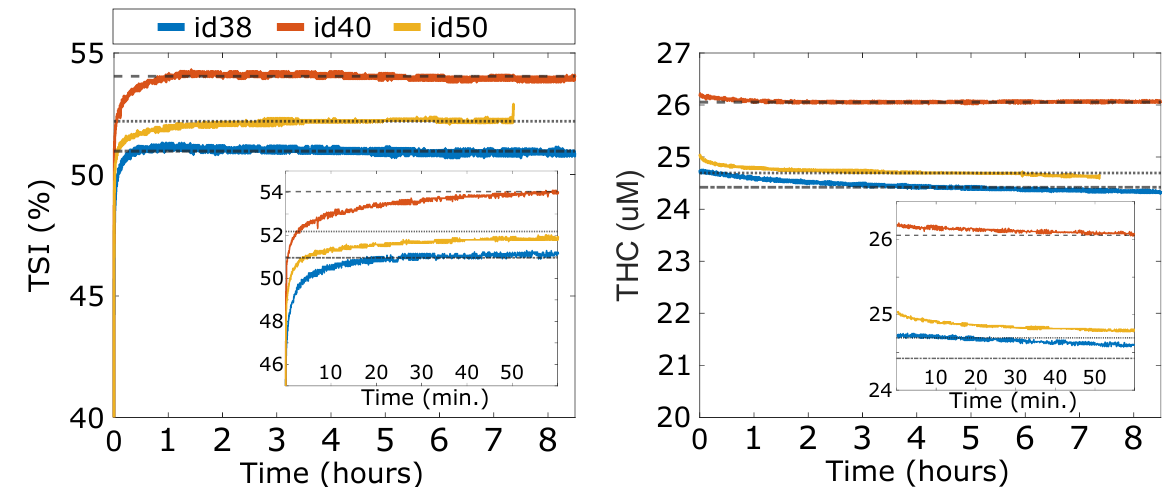
Figure 3. Overnight stability of three devices (id38, id40, and id50). In the inset, zoomed image of the TSI and THC during device